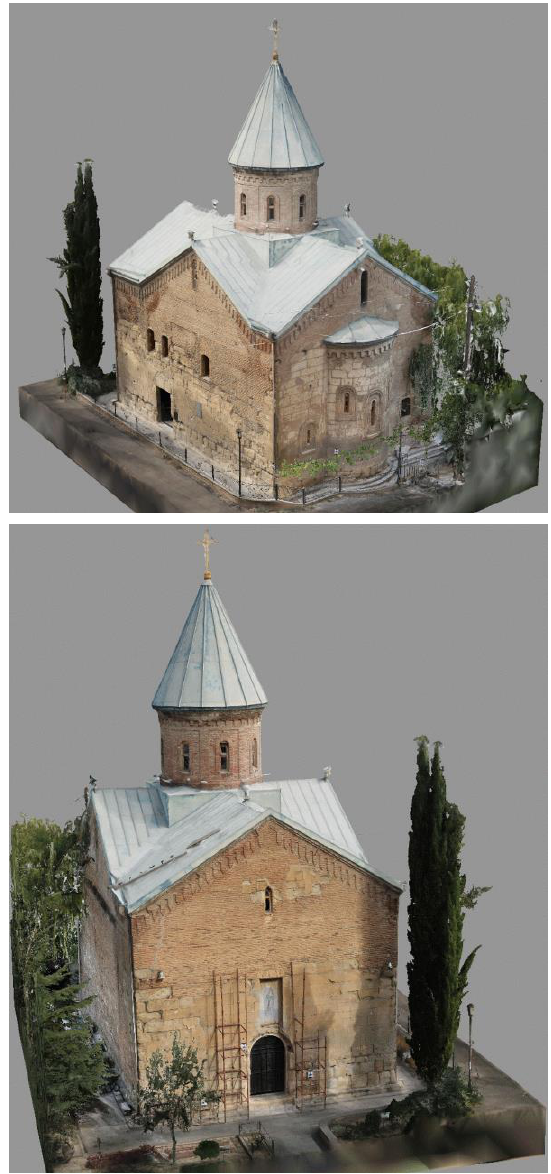
Figure 12. Meshed complete model with RealityCapture